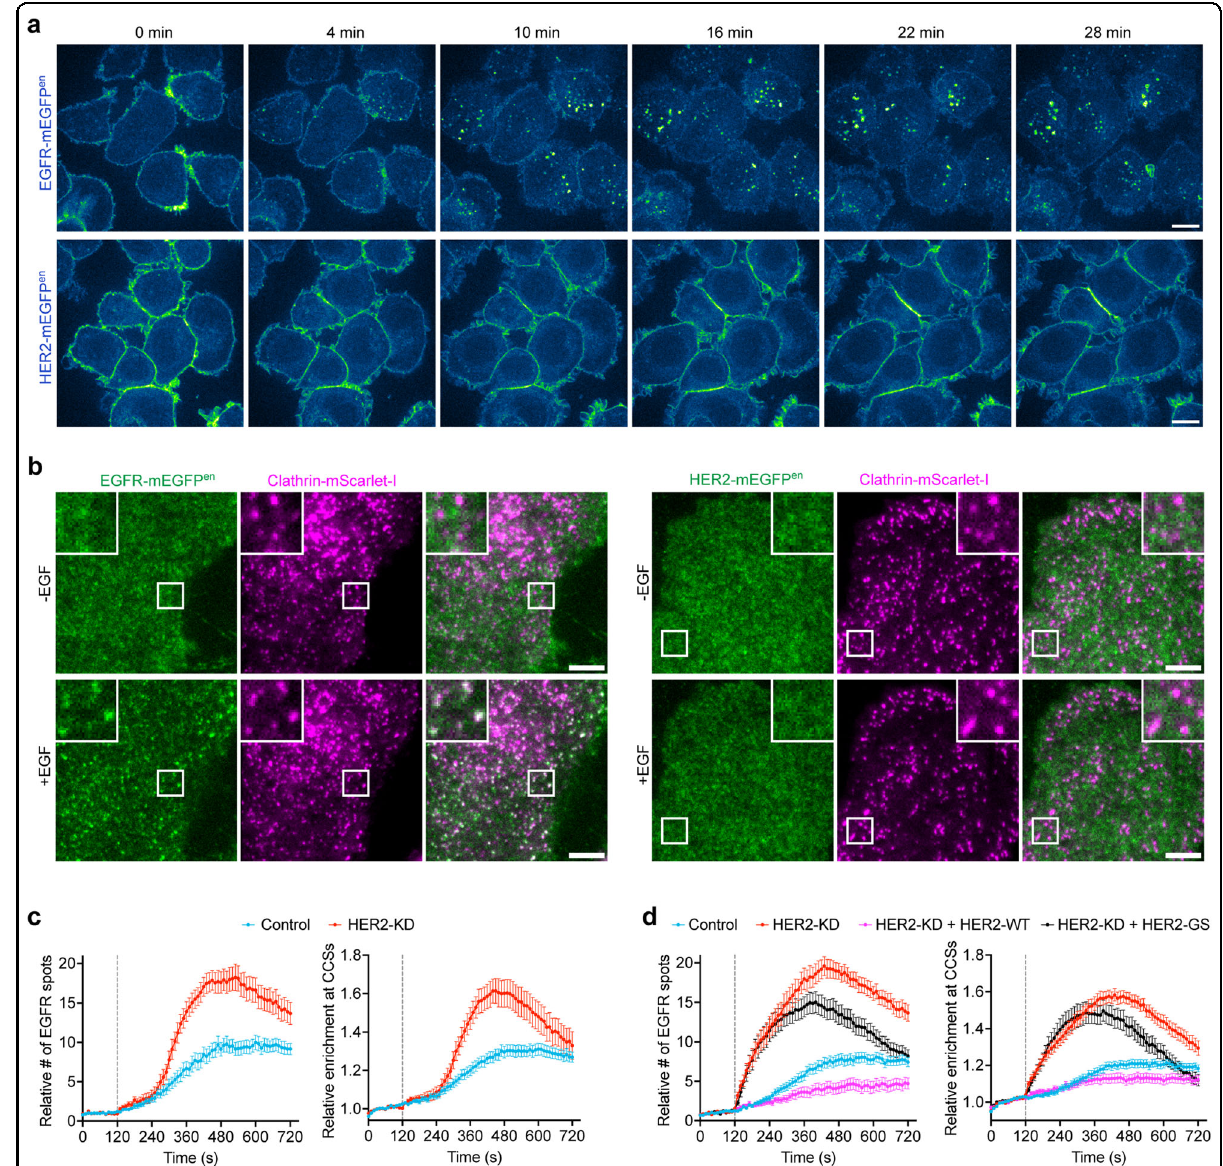
Fig. 6 Interaction of HER2 and EGFR inhibited EGFR endocytosis. a SK-BR-3 cells genome-edited for EGFR-mEGFP or HER2-mEGFP were imaged by spinning-disk confocal microscopy. Shown are images of the cells in the middle planes at indicated times after EGF (100ng/mL) treatment. Scale bars, 10 μ m. b SK-BR-3 cells genome-edited for EGFR-mEGFP or HER2-mEGFP stably expressing clathrin-mScarlet-I were imaged at the bottom surfaces by TIRF microscopy. Shown are the single frames before and 3 min after EGF treatment during the continuous time-lapse imaging. Boxed regions are enlarged and shown. Scale bars, 5 μ m. c SK-BR-3 cells genome-edited for EGFR-mEGFP and stably expressing clathrin-mScarlet-I were treated with control siRNA or siRNA targeting HER2 (HER2-KD), and then imaged at the bottom surfaces by TIRF microscopy. EGF was added at 120 s of the time-lapse imaging. The relative numbers of fl uorescence spots of EGFR-mEGFP that appeared at the plasma membrane (left panel) and the relative enrichment of EGFR-mEGFP fl uorescence in clathrin-coated structures (CCSs, right panel) during EGF stimulation are shown ( n = 23 and 19 cells). d SK-BR-3 cells genome-edited for EGFR-mEGFP and stably expressing clathrin-mScarlet-I were treated with control siRNA or siRNA targeting HER2 (HER2-KD). The cells treated with siRNA targeting HER2 were transiently transfected with the siRNA-resistant wild-type HER2 or the HER2-GS mutant and then imaged at the bottom surfaces by TIRF microscopy. EGF was added at 120 s of the time-lapse imaging. The relative numbers of fl uorescence spots of EGFR-mEGFP that appeared at the plasma membrane (left panel, n = 49, 50, 29, and 30 cells) and the relative enrichment of EGFR-mEGFP fl uorescence in CCSs (right panel, n = 43, 49, 28, and 30 cells) during EGF stimulation are shown. Error bars show means ±